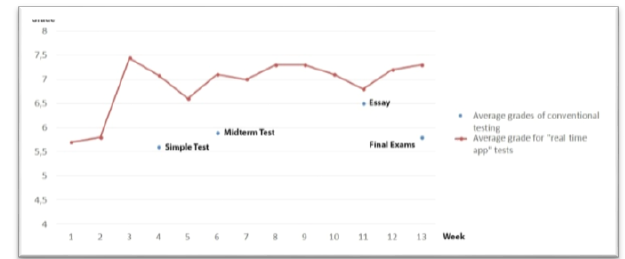
Figure 9. Conventional Testing vs Exantas